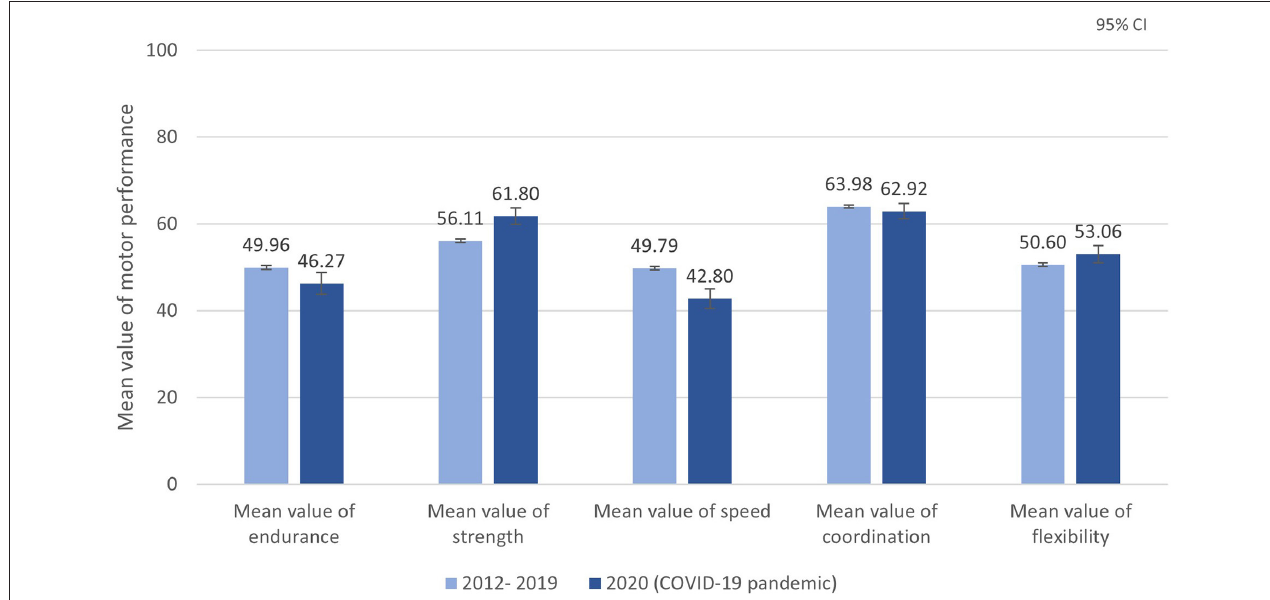
FIGURE 2 | Mean values of MP for the five dimensions according to field testing period.